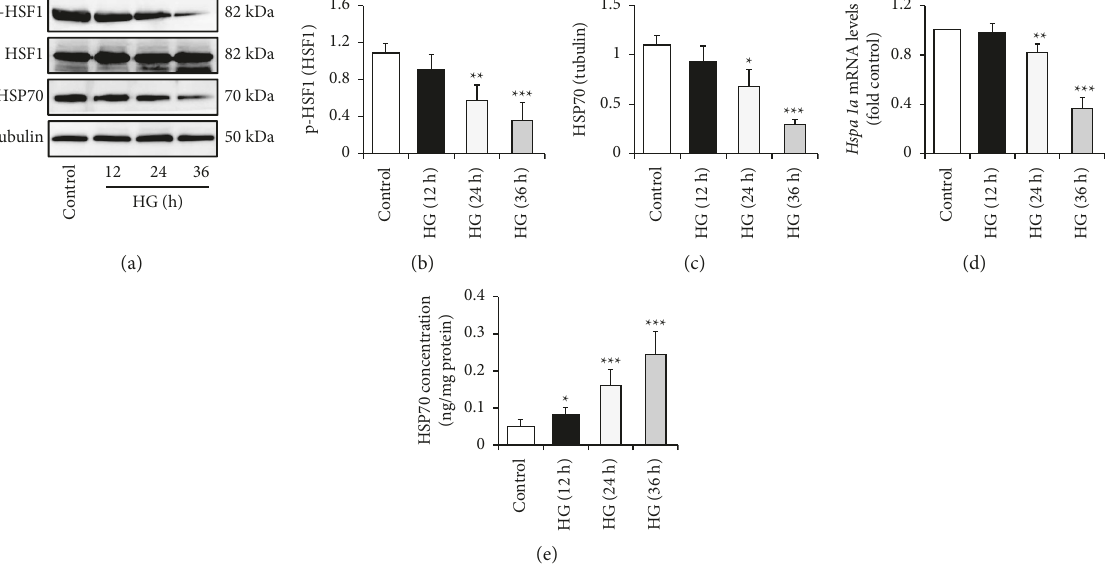
Figure 3: Effect of HG on iHSP70 levels. HUVECs were exposed to NG (5.5mM glucose) or HG (30mM glucose) media for the indicated times. (a) Effect of HG on HSF1 phosphorylation and iHSP70 levels. (b) Quantification of HSF1 phosphorylation in (a). (c) Quantification of iHSP70 levels in (a). (d) Effect of HG on Hspa1a mRNA levels. (e) Effect of HG on HSP70 concentration in the culture media. Data are expressed as means ± SD ( n � 3). ∗ P < 0 . 05, ∗∗ P < 0 . 01, and ∗∗∗ P < 0 . 001 versus control (NG)